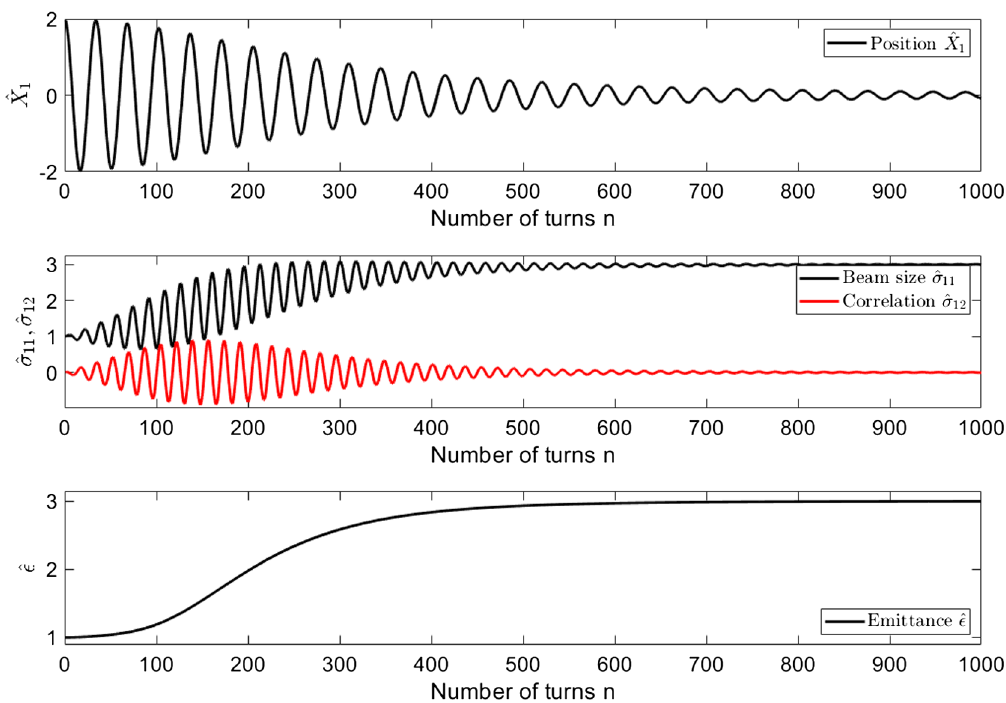
FIG. 2. The centroid X 1 (top), the beam matrix elements σ 11 and σ 12 (middle), and the emittance (bottom) as a function of the turn number n for a matched beam that is injected with initial offset X 1 ¼ 2 . The parameters used are μ = 2 π ¼ 0 . 028 and κε 0 ¼ 0 . 001 . The vertical axes are normalized to appropriate powers of ε 0